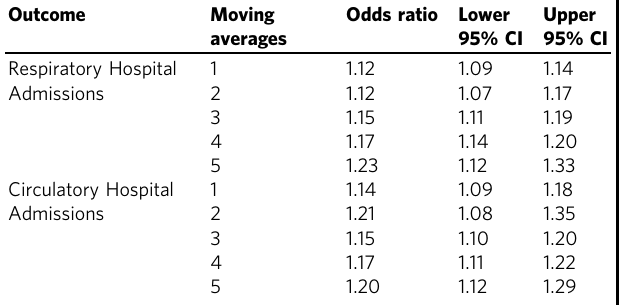
Table 3 Odds ratio and 95% CI representing the national average (from meta-analysis) hospital admissions associated with wild fi re-related PM 2.5 in wild fi re waves in Brazil (2008 – 2018) for 1 – 5 moving